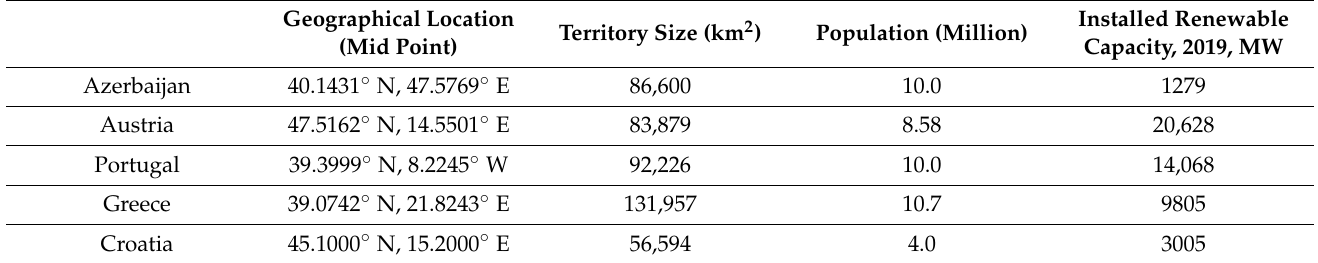
Table 2. Best practice countries selected for this study